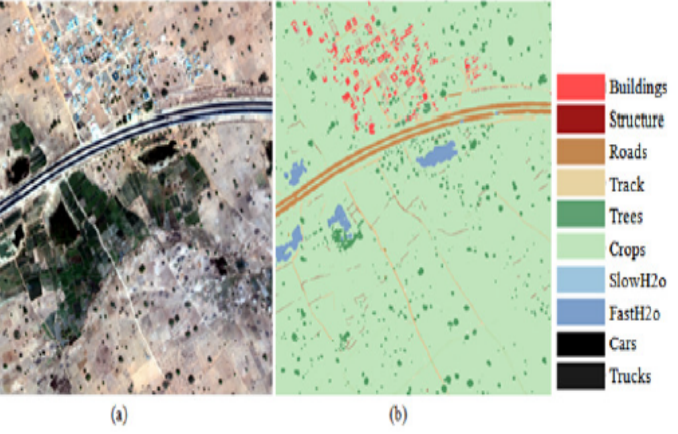
Figure 13. 16-band images results: ( a ) the real image, ( b ) the result after